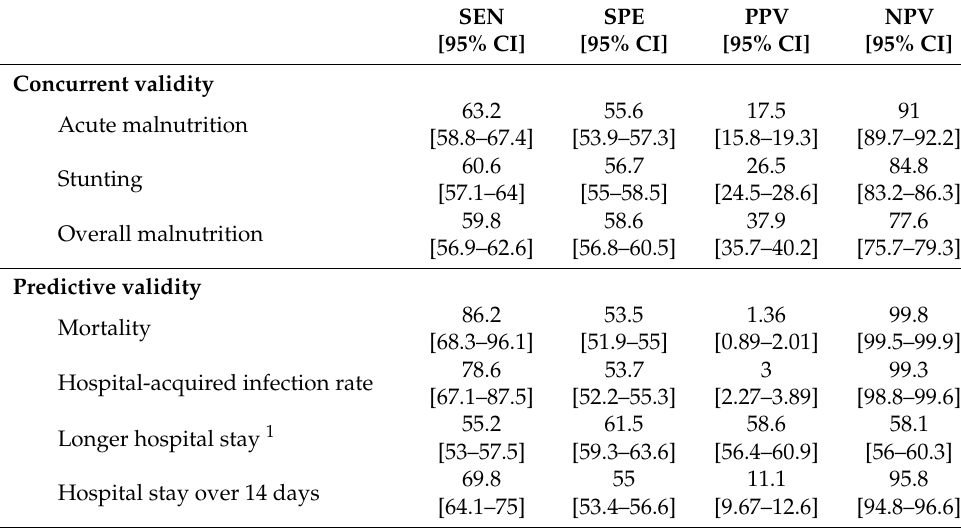
Table 3. Concurrent and predictive validity of STRONGkids.